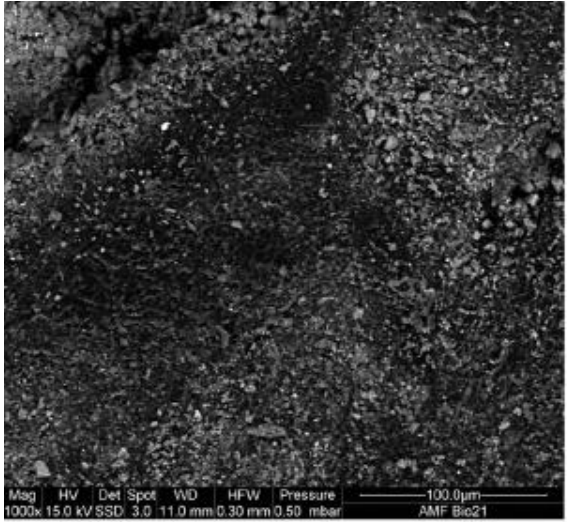
Figure 5. SEM of rubber particle [40]: used as per Elsevier permission. Khatib and Bayomy [41] claim that adding more rubber to concrete reduces both the slump and unit weight. At a 5% crumb rubber content, the slump on rubber without fibers and rubber with fibers fell by 6.67% and 12.50%, respectively. The slump then gradually decreases for rubberized concrete with a crumb rubber content of 10% or 15%. Rubber without fibers and rubber with fibers slumped the least at a 20% crumb rubber concentration, measuring 2 cm and 2.5 cm, respectively. This represents a decrease of 71.43% and 64.29% in comparison to control mixes [42].